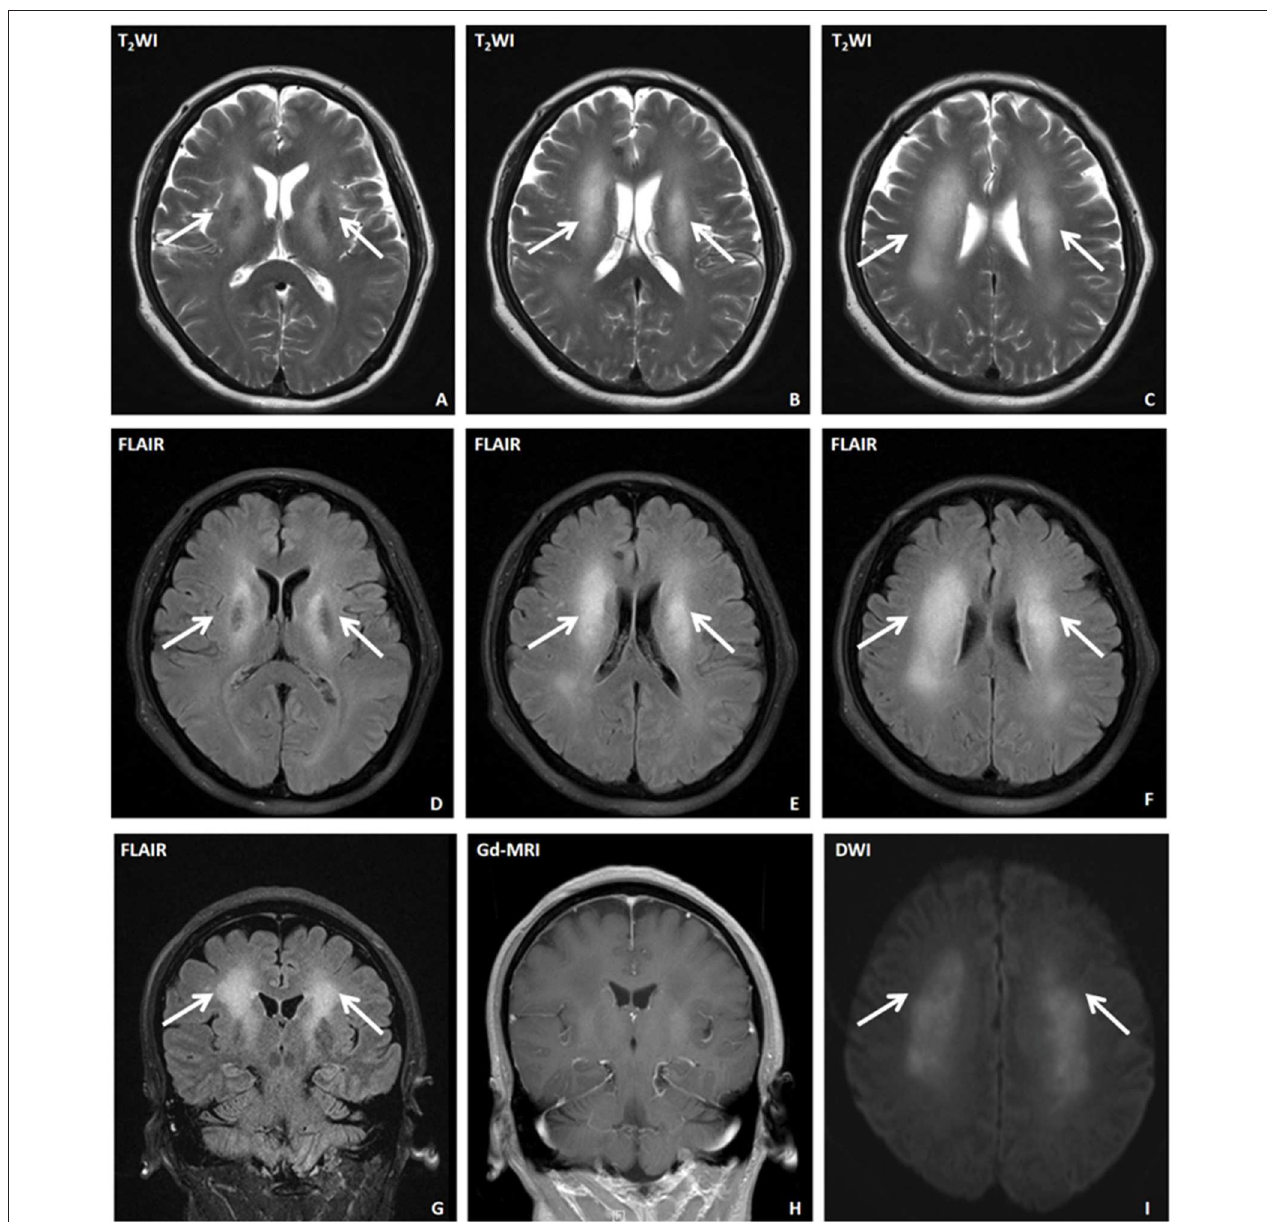
FIGURE 1 | Cranial magnetic resonance imaging (MRI) of a patient with anti-CV2 autoimmune encephalitis. (A–C) T 2 WI axial images. (D–F) FLAIR axial images. (G) FLAIR coronal scan. (H) Enhanced MRI. (I) Diffusion-weighted MRI. The arrows indicate abnormal signals in the white matter area of the bilateral lateral ventricles and bilateral internal capsules. No significant enhancement was